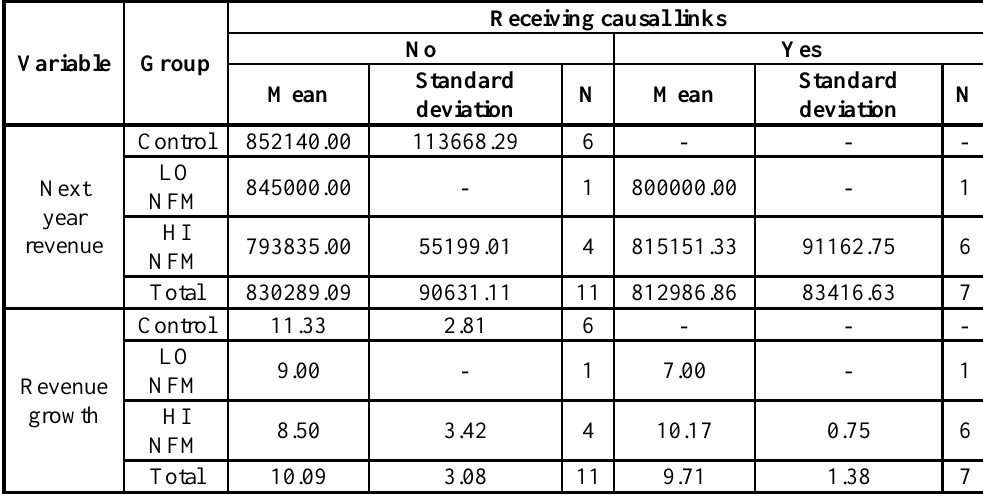
Table 9. Descriptive statistics (non-financial information with causal links for investors with high knowledge in million